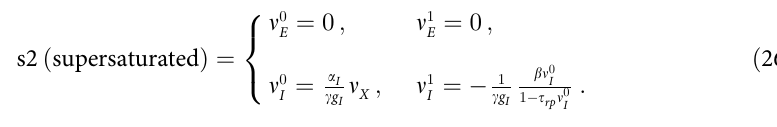
In the strong coupling limit, the inhibitory rate increases linearly with the external drive while the excitatory population remains silent due to overwhelming inhibition. Applying the same